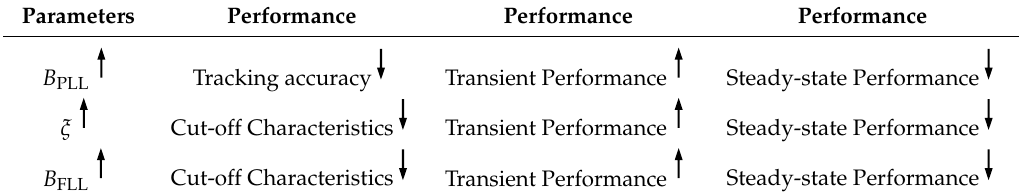
Table 1. Influence of parameters on both accuracy and transient response.